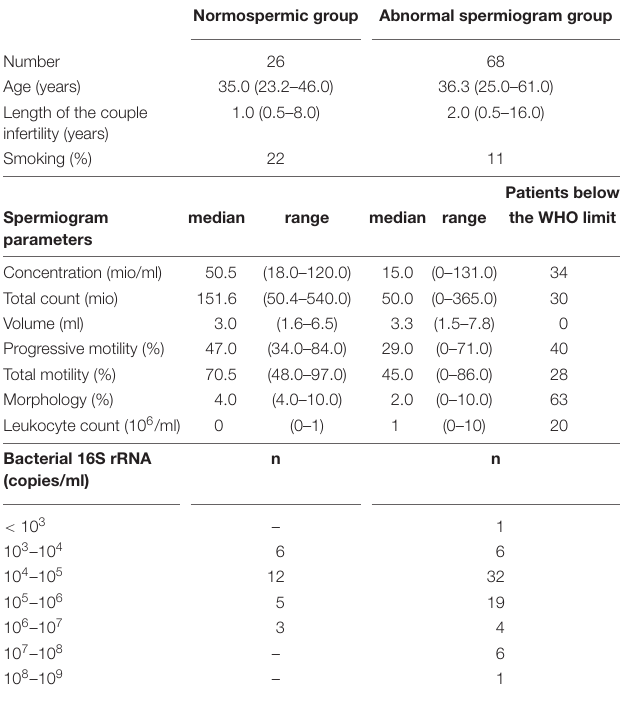
TABLE 1 | Detailed information about general information, spermiogram parameters and Bacterial 16S rRNA load in the normal and abnormal spermiogram